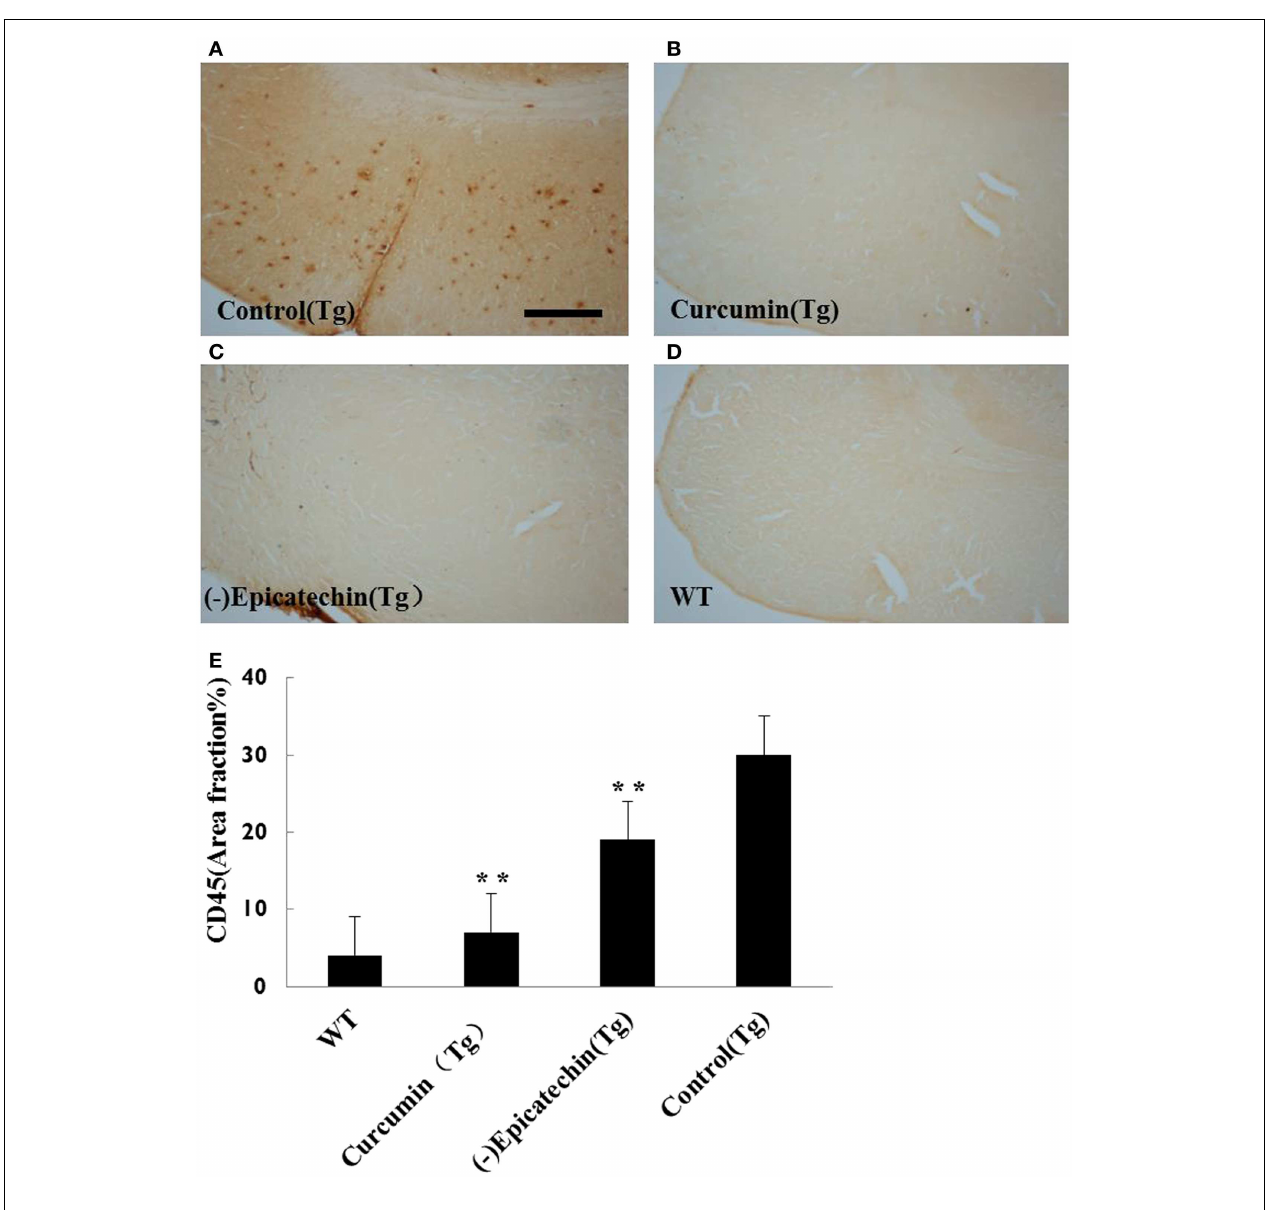
diet, (E) Comparison of CD45 area fraction in neocortex and hippocampus among groups. Statistical analysis showed a significant decrease in the number of microgliosis in the brain treated with ( − )epicatechin and curcumin diets. P < 0.05 versus APP/PS1 transgenic mice fed with control diet. Scale bar = 0.5mm. Original magnification, 4 ×